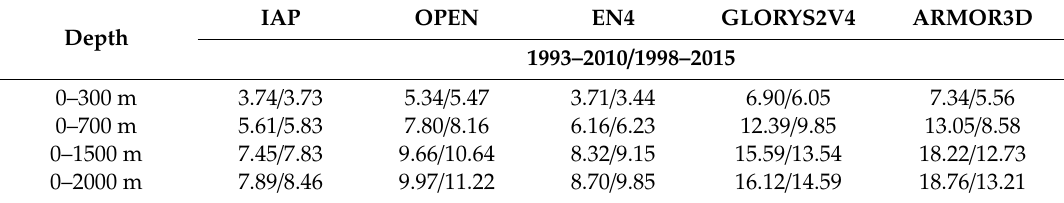
Figure 4. Near-global OHC300 (unit: Joule) excluding polar regions. The anomaly is with respect to 1993–2015 period. All datasets were smoothed with a one-year moving average. Before the moving average procedure, seasonal cycles averaged from the first or last three years were respectively padded to the time-series. The name of each product is shown in the legend. For OPEN, ensemble-mean is shown in the black line, while the uncertainty was estimated by taking three standard deviations across six ensemble members. Notice that the National Centers for Environmental Information (NCEI) has a three-month temporal resolution, while all other datasets are monthly. Table 2. Warming rates of the global ocean OHC at different depths in ×10 22 J/decade.